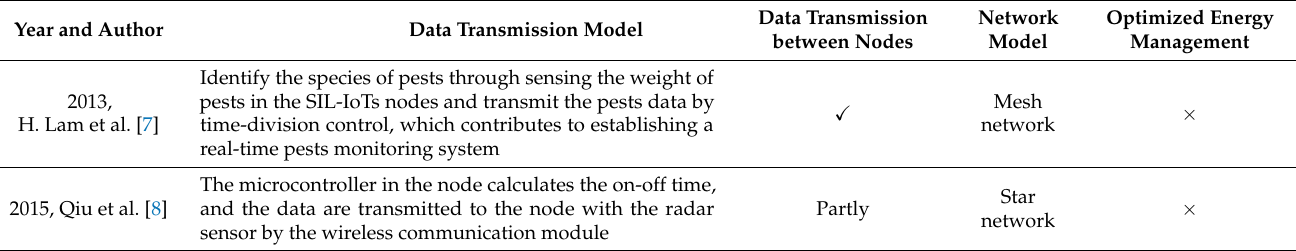
Table 1. Data Transmission Status in 2 Related Research Works of